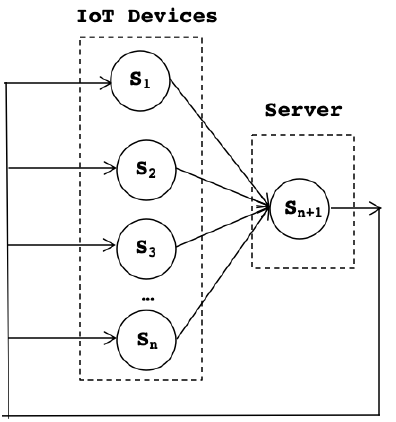
Figure 5. Service scheme at server and IoT